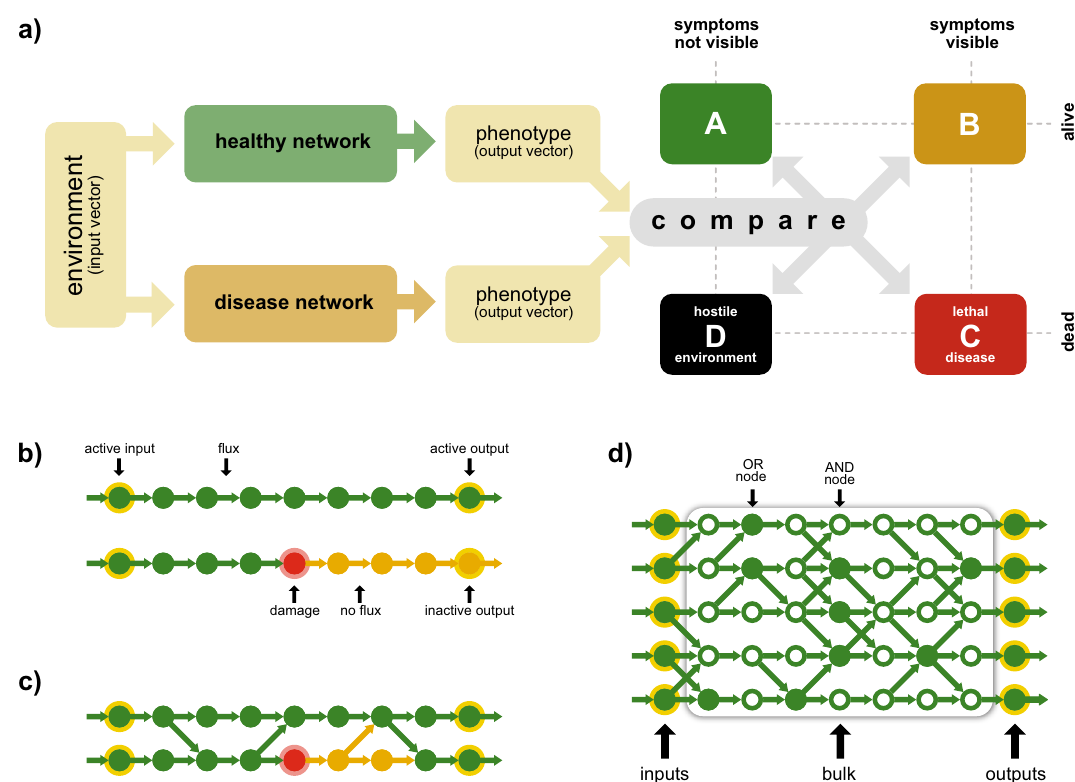
Figure 1. ( a ) Flow chart of our investigation: The outputs of a healthy and a defect (disease) network (receiving the same input vector) are compared. Depending on their difference they are assigned to a specific class: Class A, if both outputs are equal (no disease), class B, if the disease network has a lower but non-zero output (symptomatic disease), class C, if the disease network has zero output, while the healthy network has a non-zero output (lethal disease), class D, if both the healthy and the disease network have zero output. ( b ) Definition of node states and visual representation of the effect of a non-functional node. ( c ) Illustration of branching and visual representation of compensating a defect via interacting pathways. ( d ) Schematic representation of the full model and illustration of the layer